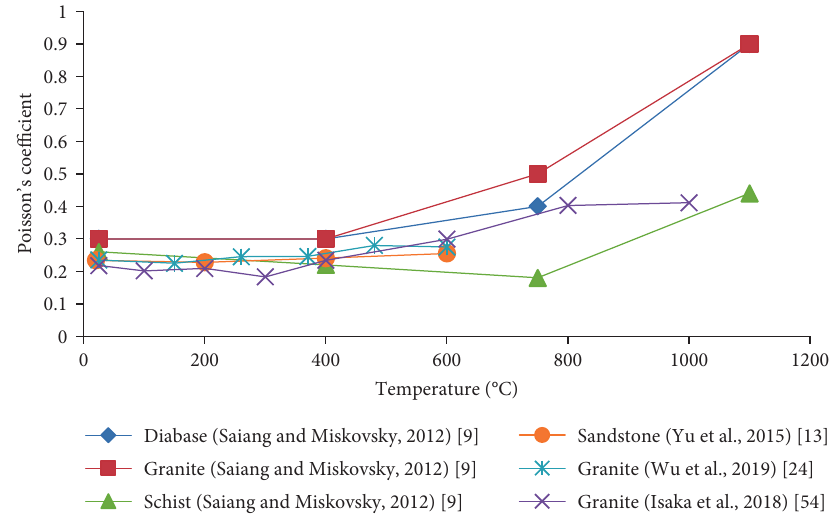
Figure 7: Static Poisson’s ratio of sandstone as a function of